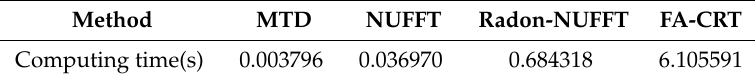
Table 3. Computing time of the four